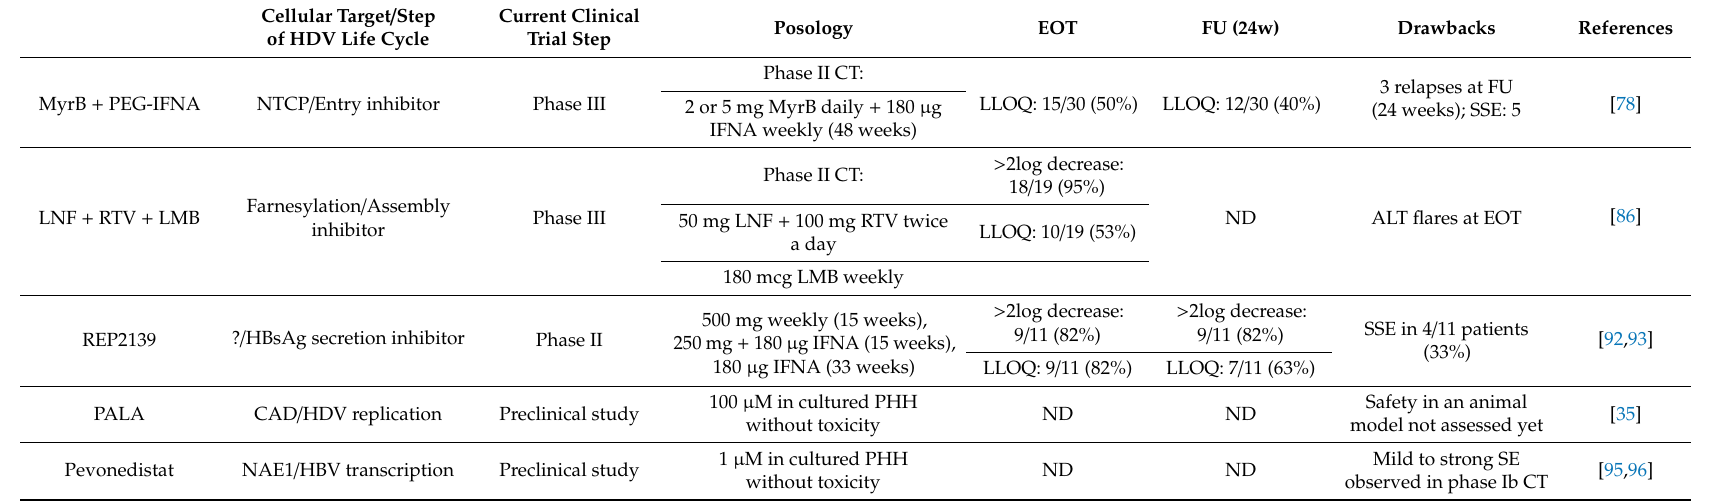
Antiviral molecules in clinical trial. MyrB: myrcludex B; PEG-IFNA: pegylated-interferon-alpha-2a; LNF: lonafarnib; RTV: ritonavir;